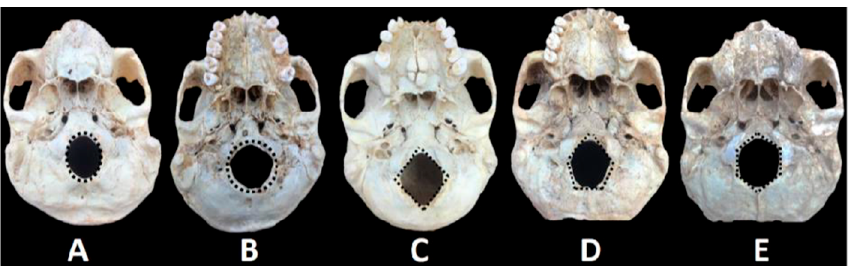
Figure 4. Anatomical variation of shape of the foramen magnum under the base of the skull: ( A ) oval shape, ( B ) round shape, ( C ) tetragonal shape, ( D ) pentagonal shape and ( E ) hexagonal shape.